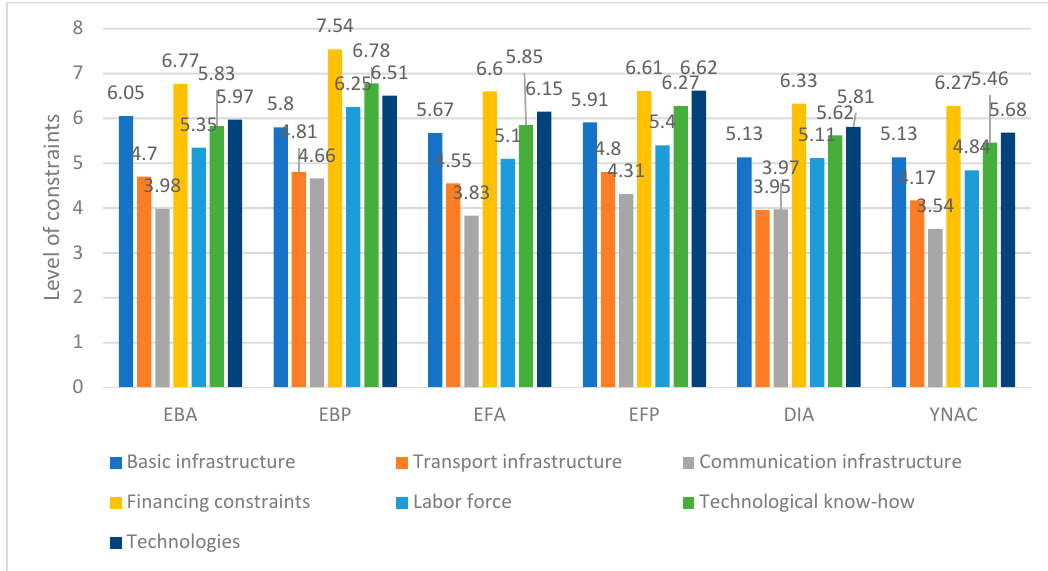
constraints in technologies.